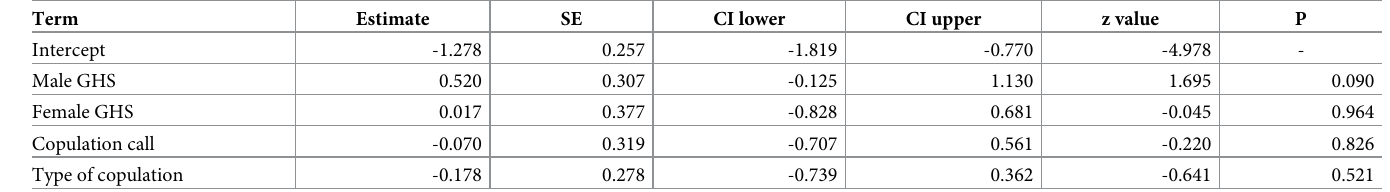
Table 4. Post-copulatory grooming (PCG)-presence model. Binomial GLMM evaluating if the likelihood of PCG was affected by the male and female GHS, presence of copulation calls, and type of copulation (ejaculatory vs. non-ejaculatory).